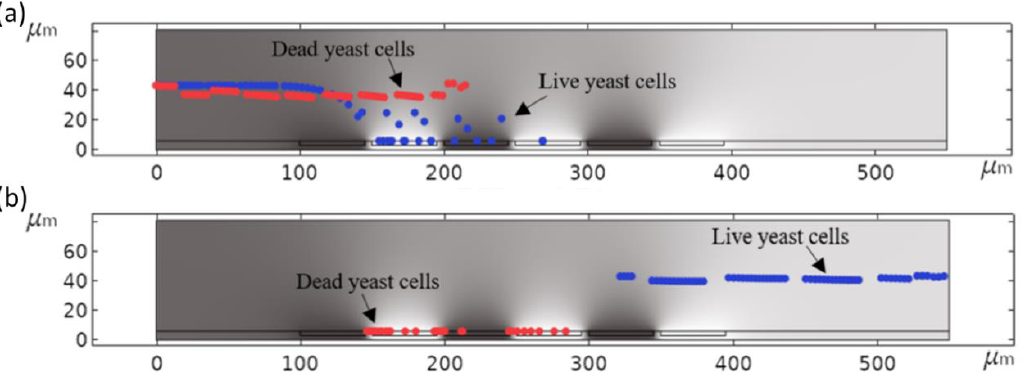
Figure 7. Simulation studies performed by Ettehad et al. [15] showing the DEP separation of live and dead yeast cells. ( a ) Frequency: 3 MHz; ( b ) Frequency: 90 kHz. dead yeast cells. ( a ) Frequency: 3 MHz; ( b ) Frequency: 90